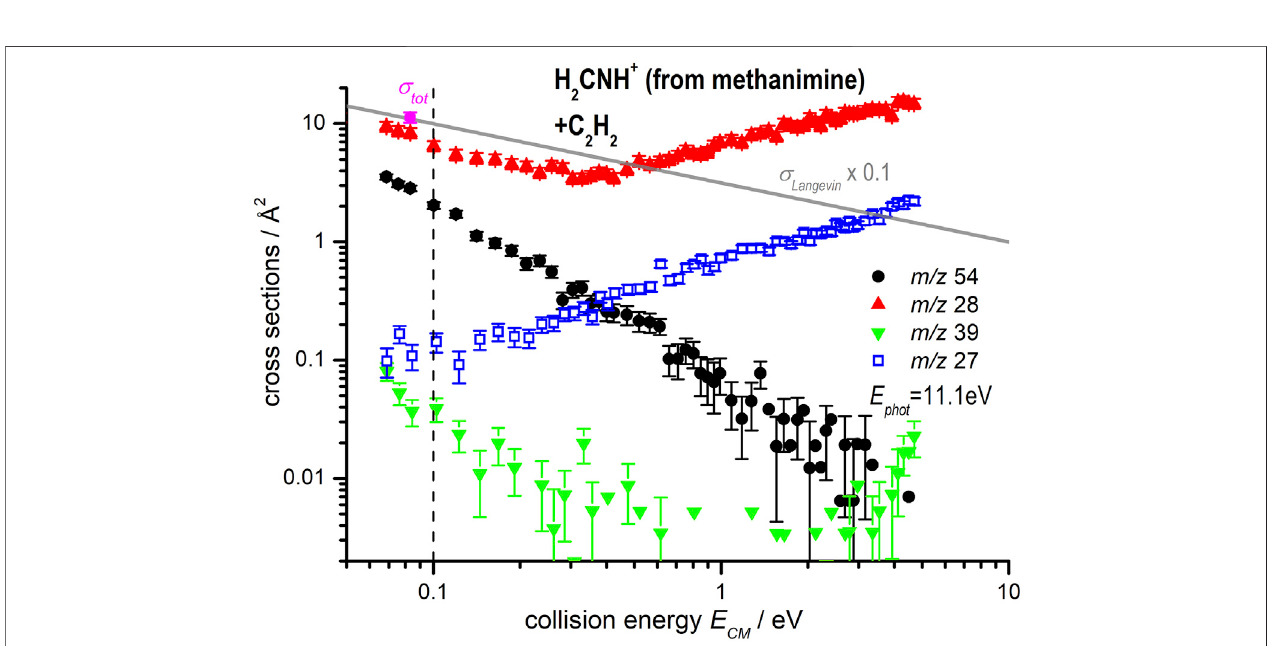
(cid:129) FIGURE5 | Reactive cross sections asafunction of E CM for thereaction ofH 2 CNH + (from methanimine) with C 2 H 2 . The photon energy is fi xedat E phot (cid:2) 11.1 eV. The vertical dashed line isat the collision energy at which data have been collected as a function of E phot (see Figure 3 ). The grey solid lineis the Langevin CSs (rescaled by a factor 0.1 to fi t in the fi gure). The magenta point is the total reactive CS ( σ tot ) used to calculate the total rate constant k tot reported in Table 2 .